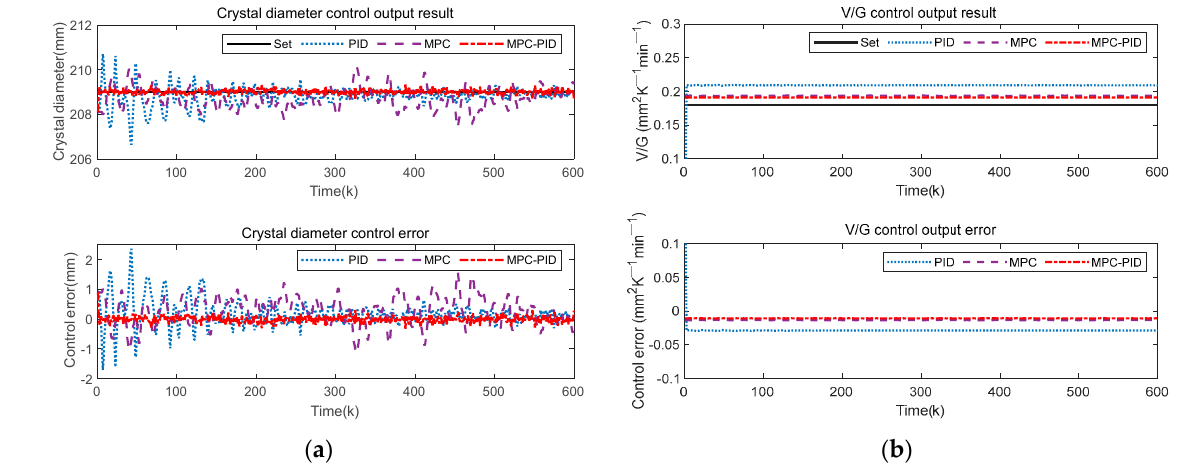
Figure 11. Control results of different control methods under Gaussian noise disturbance: ( a ) crystal diameter control output results; ( b ) V/G control output results.